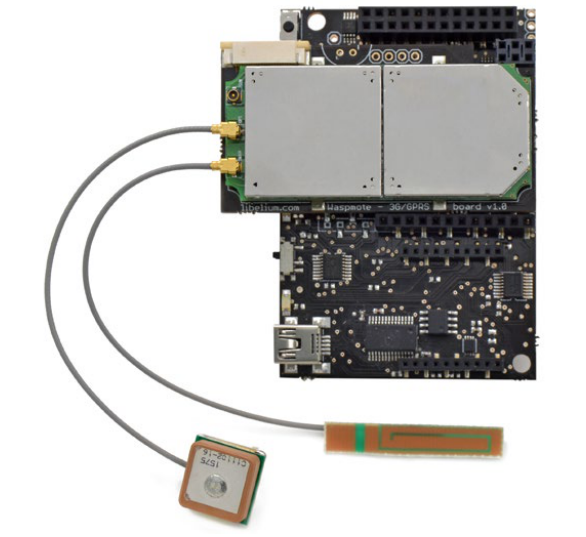
Figure 8. SIM5218E. 3G-GPRS module for the spare